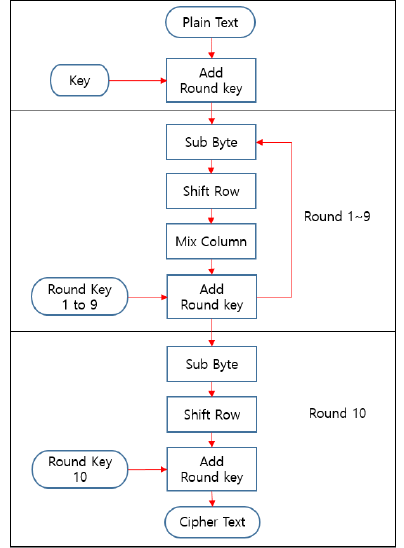
Figure 2. AES-128 encryption/decryption